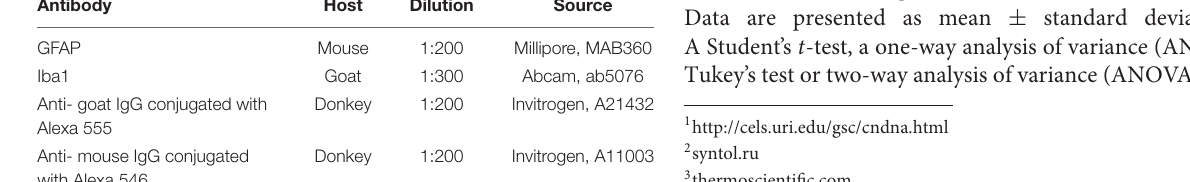
TABLE 2 | Primary and secondary antibodies used in immunofluorescent staining.